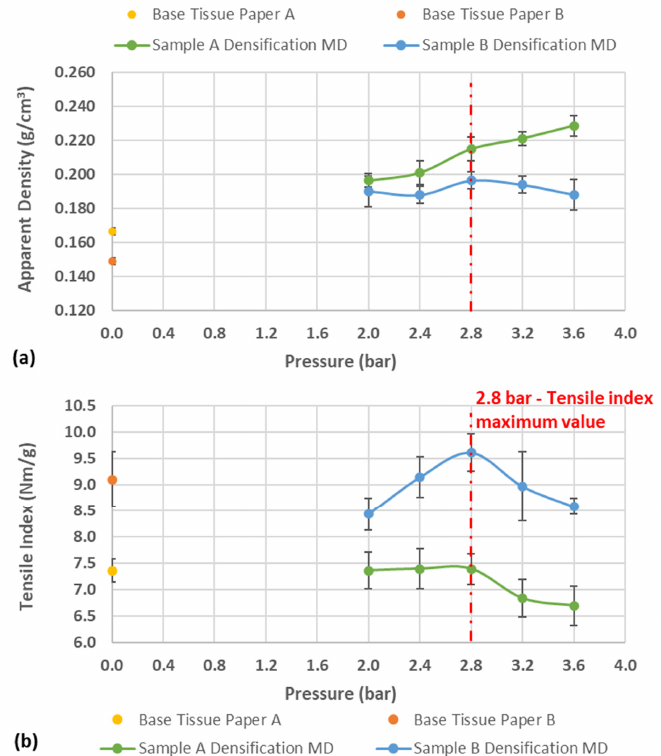
Figure 5. Results obtained for: ( a ) apparent density and ( b ) tensile index with the pressure increase in the base tissue paper densification of the samples A and B . Figure 6 allows the observation of the SEM images of samples A and B, at two magni- fications (×100 and ×300) at peak pressures before and after it. The measurements in yellow correspond to the crepe wave height ( μ m) without any mechanical compression, which has a different interpretation than the thickness of tissue paper measured by the ISO standard.